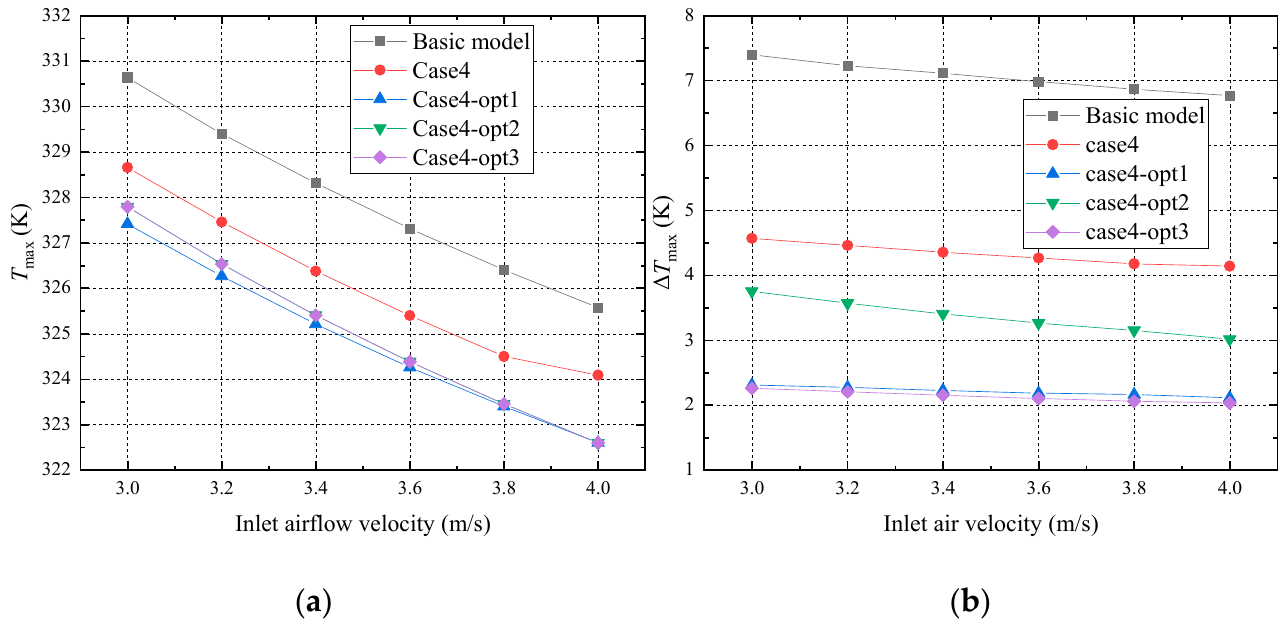
Figure 15. Comparison of T max and Δ T max in different cases under various inlet airflow velocities; ( a ) T max of various cases; ( b ) Δ T max of various cases.